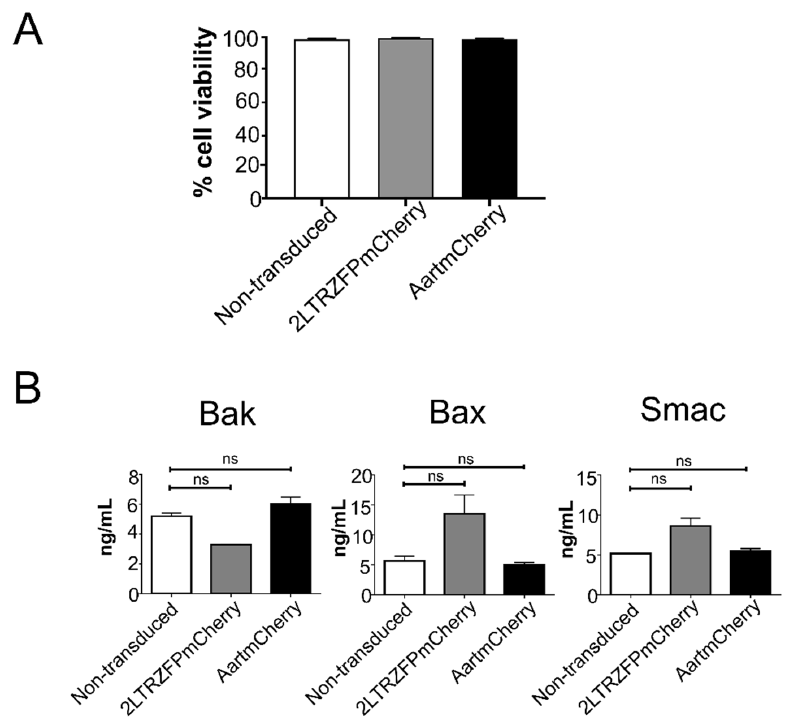
Figure 2. Viability of CD34 + HSPCs after transduction with the 2LTRZFPmCherry or the AartmCherry. ( A ) Percentages of cell viability of CD34 + HSPCs transduced with the 2LTRZFPmCherry (grey bar) or the AartmCherry (black bar), and the non-transduced cells (white bar). All data are represented as mean ± SEM. ( B ) The expression levels of pro-apoptotic proteins; Bak, Bax, and Smac in the CD34 + HSPCs transduced with 2LTRZFPmCherry or the AartmCherry compared to the non-transduced cells. Data are represented as mean ± SEM. ( n = 3), p = 0.33, ns = not significant.